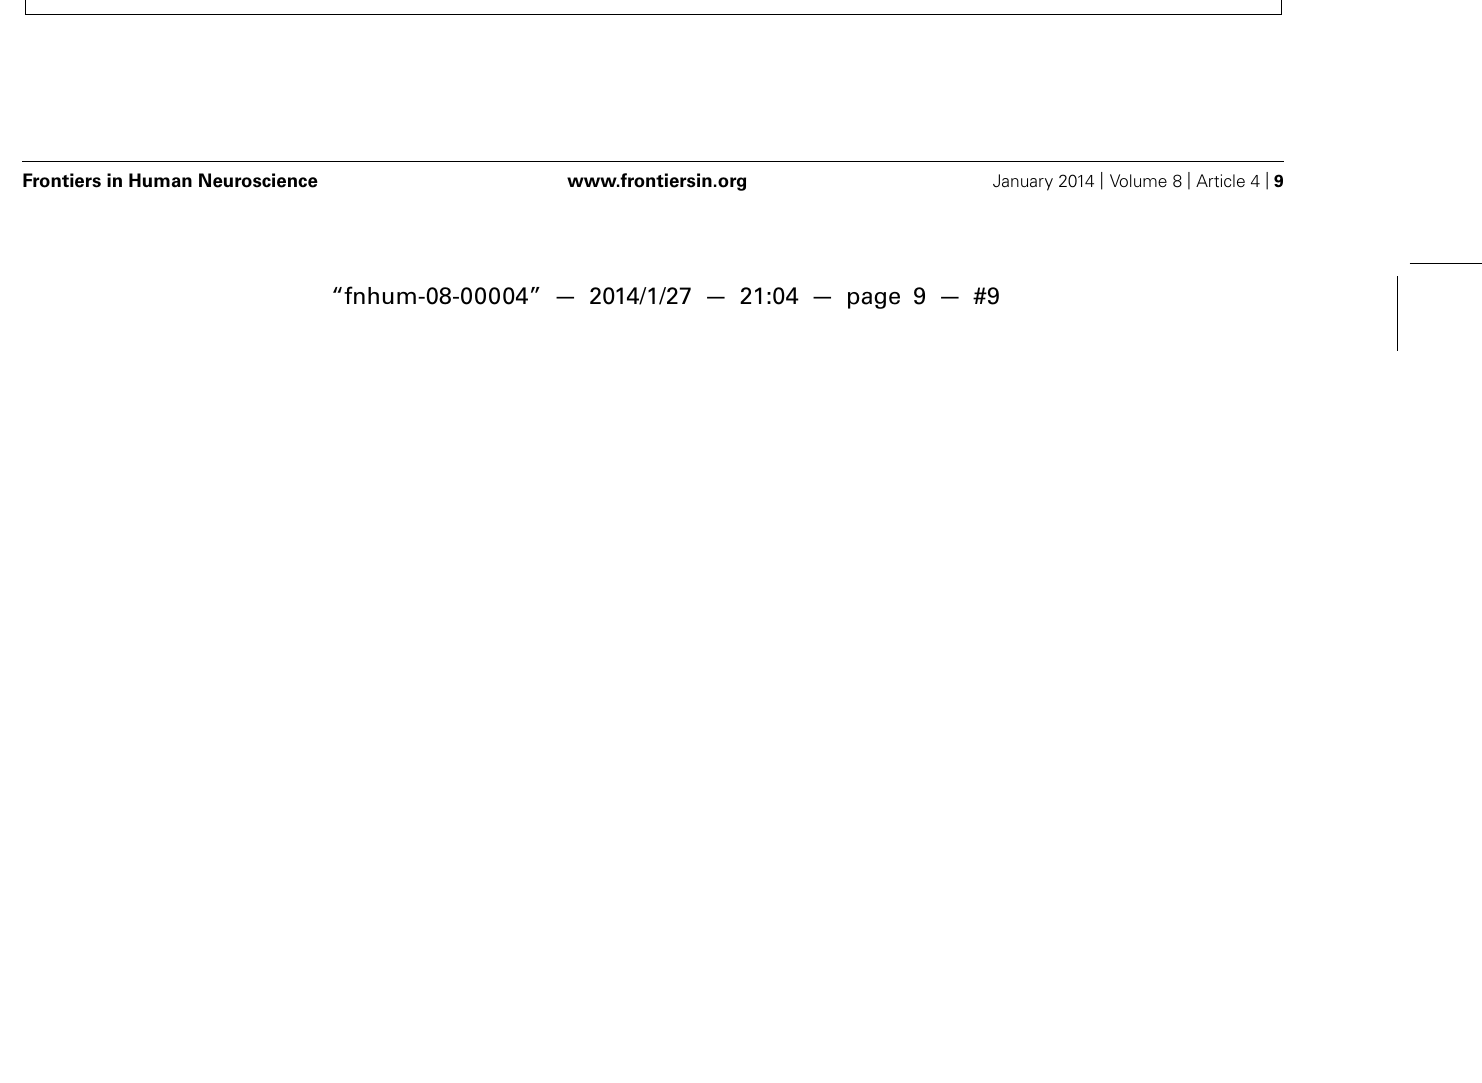
FIGURE 7 | Component 9 (C9). For each component, (A–C) are as in Figure 4